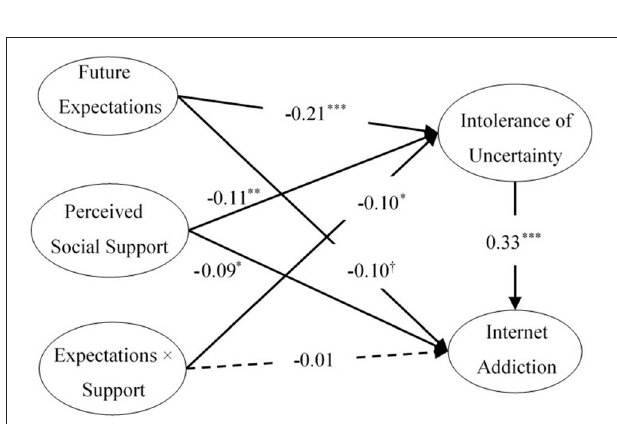
FIGURE 3 | The moderating effect of perceived social support. The dotted line indicates that the coefficients are not significant. ** p < 0.01, *** p <